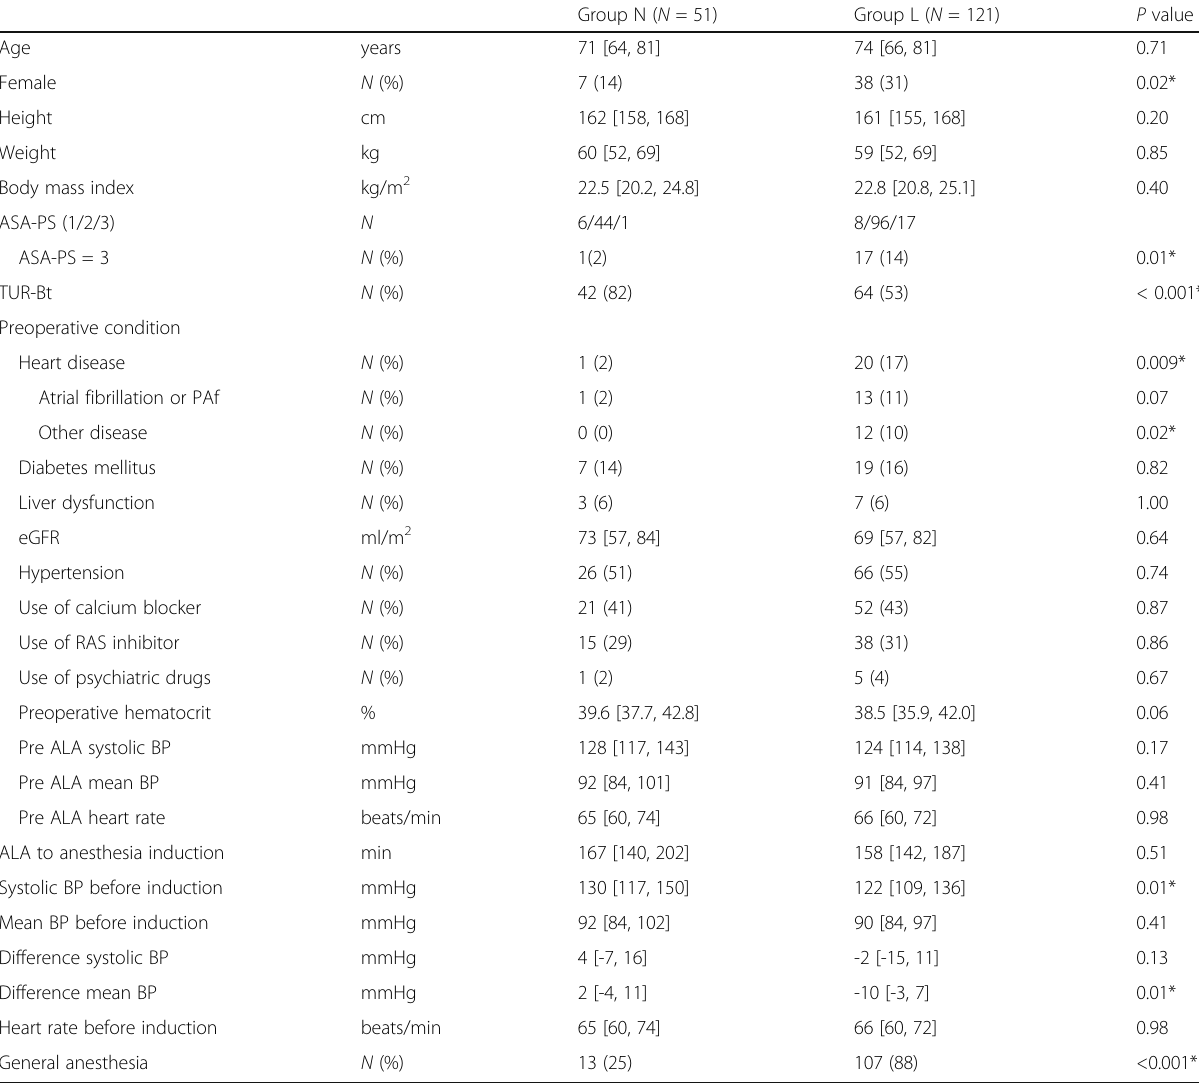
Table 1 Patient background and pre-anesthesia